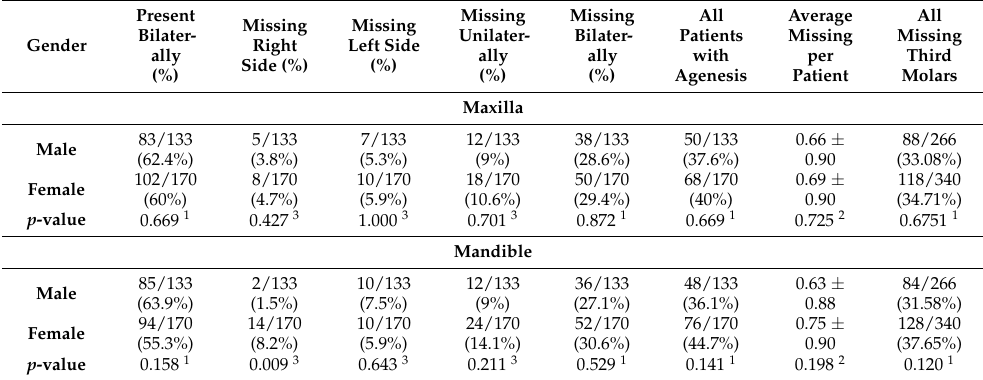
Table 1. Distribution of the symmetry patterns of third molar agenesis per jaw in males and females with agenesis of teeth other than the third molars, overall and for each quadrant.